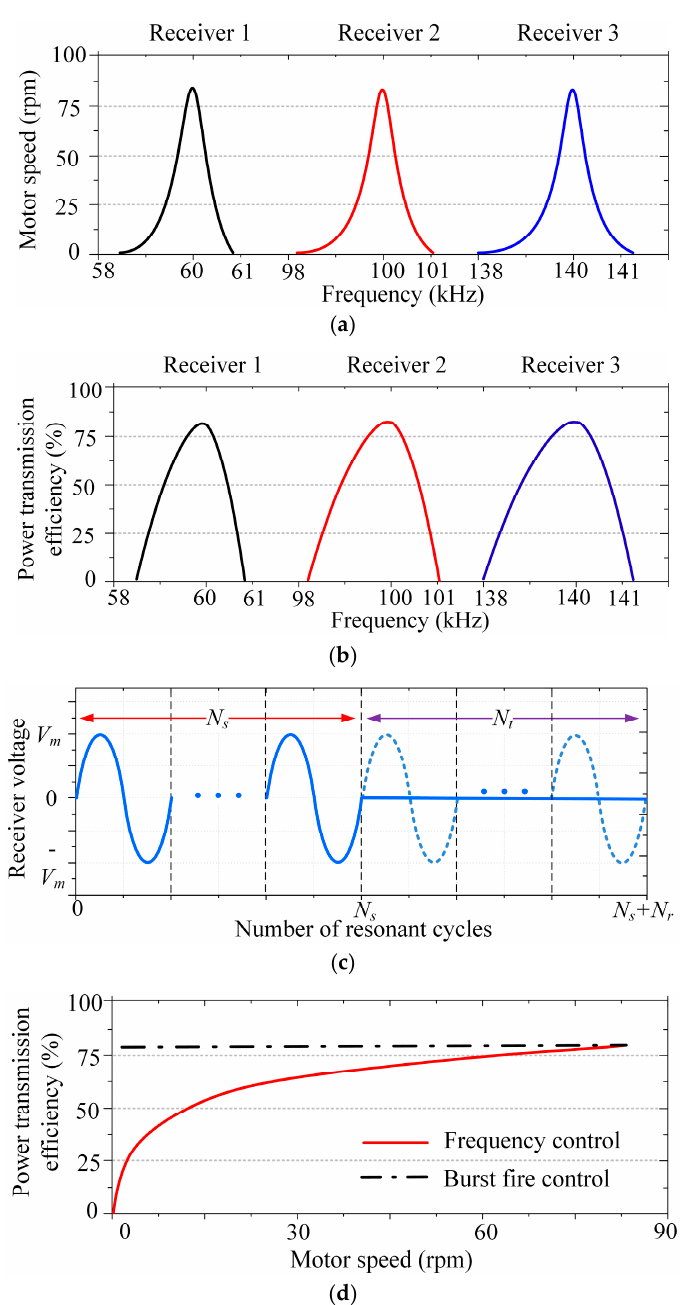
Figure 2. Wireless power transfer (WPT) system with selectivity: ( a ) motor speeds resulted; ( b ) power transmission efficiencies; ( c ) burst fire control of WPT from transmitter to receiver; and ( d ) efficiency comparison between frequency control and burst fire control for speed control of DC motor 2 .